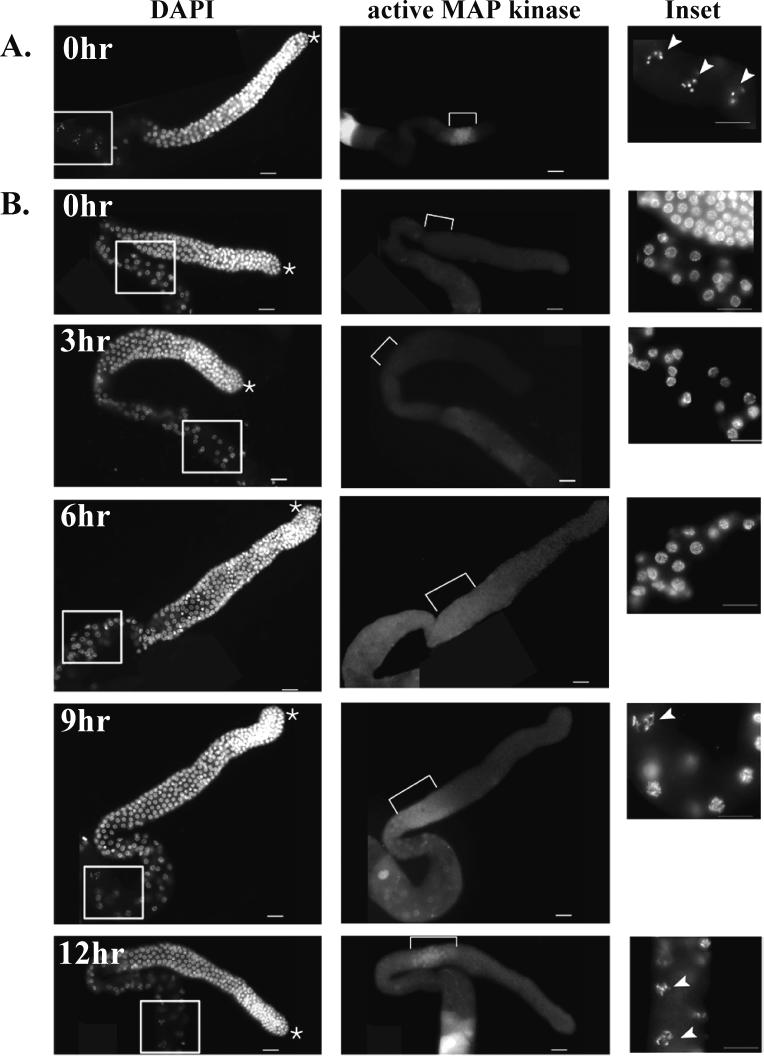
Meiotic Progression and MAP Kinase Activation Is Restored after Shift to Permissive TemperatureDissected gonads were stained with DAPI (left column) and α-diP MAP kinase (middle column). Boxed area in left column is enlarged in right column (inset) to show germ cell morphology during meiotic progression. Asterisks indicate distal end of germ line. Arrowheads indicate nuclei in diakinesis. Brackets indicate region with activated MAP kinase staining.(A) Gonads from control animals.(B) mpk-1 gonads at 26 °C (0 h) and following shift to 15 °C (3–12 h).All gonads also carry fem-1(hc17) and unc-79(e1068) alleles. Scale bar, 20 μm.